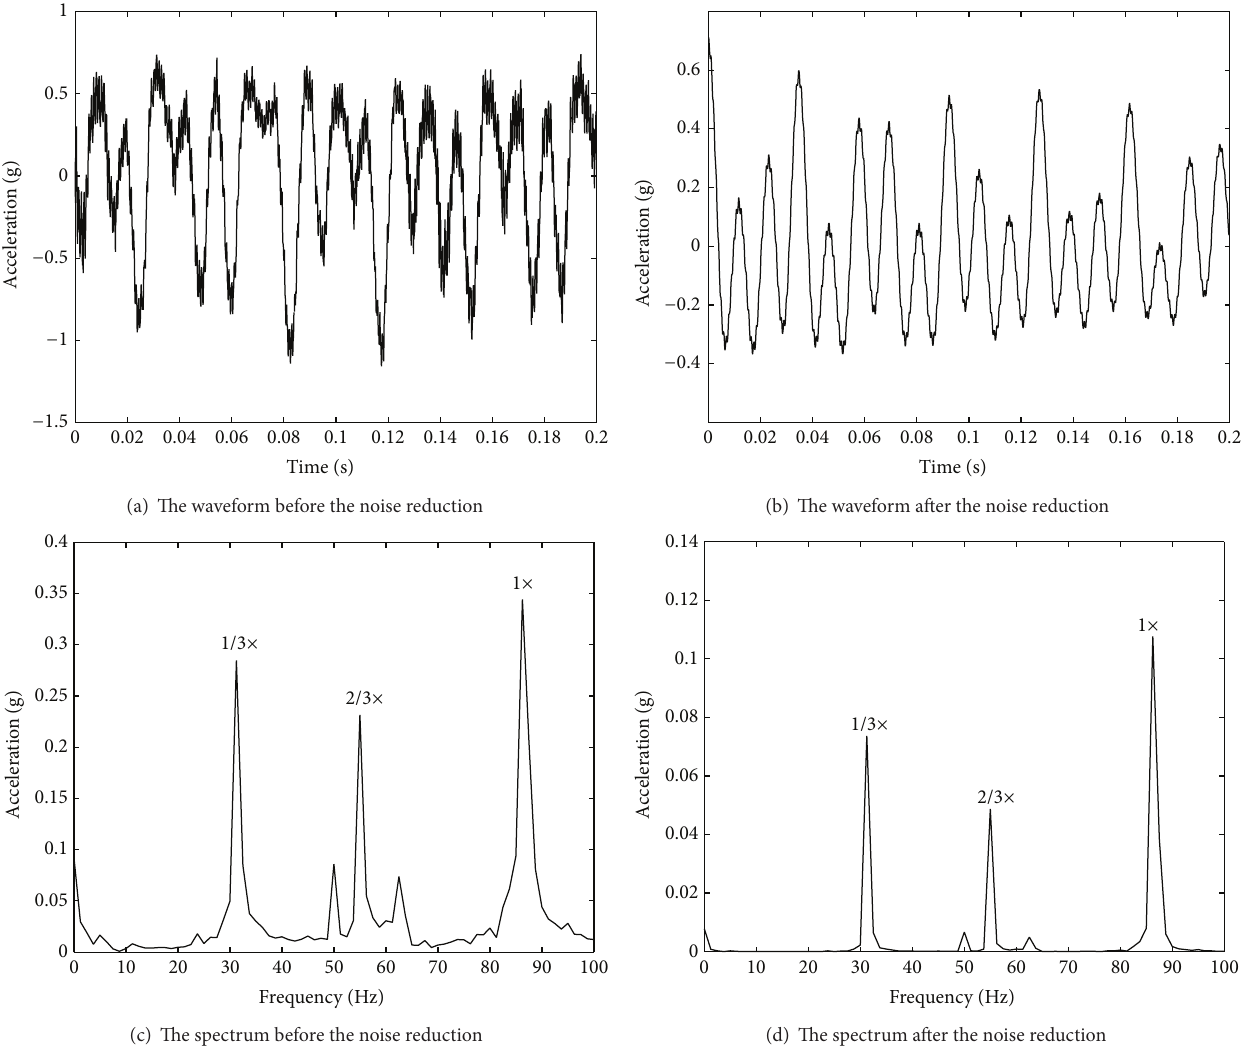
Figure 29: Waveform and frequency spectrum before and after the noise reduction when frequency is 3𝑓 𝑛